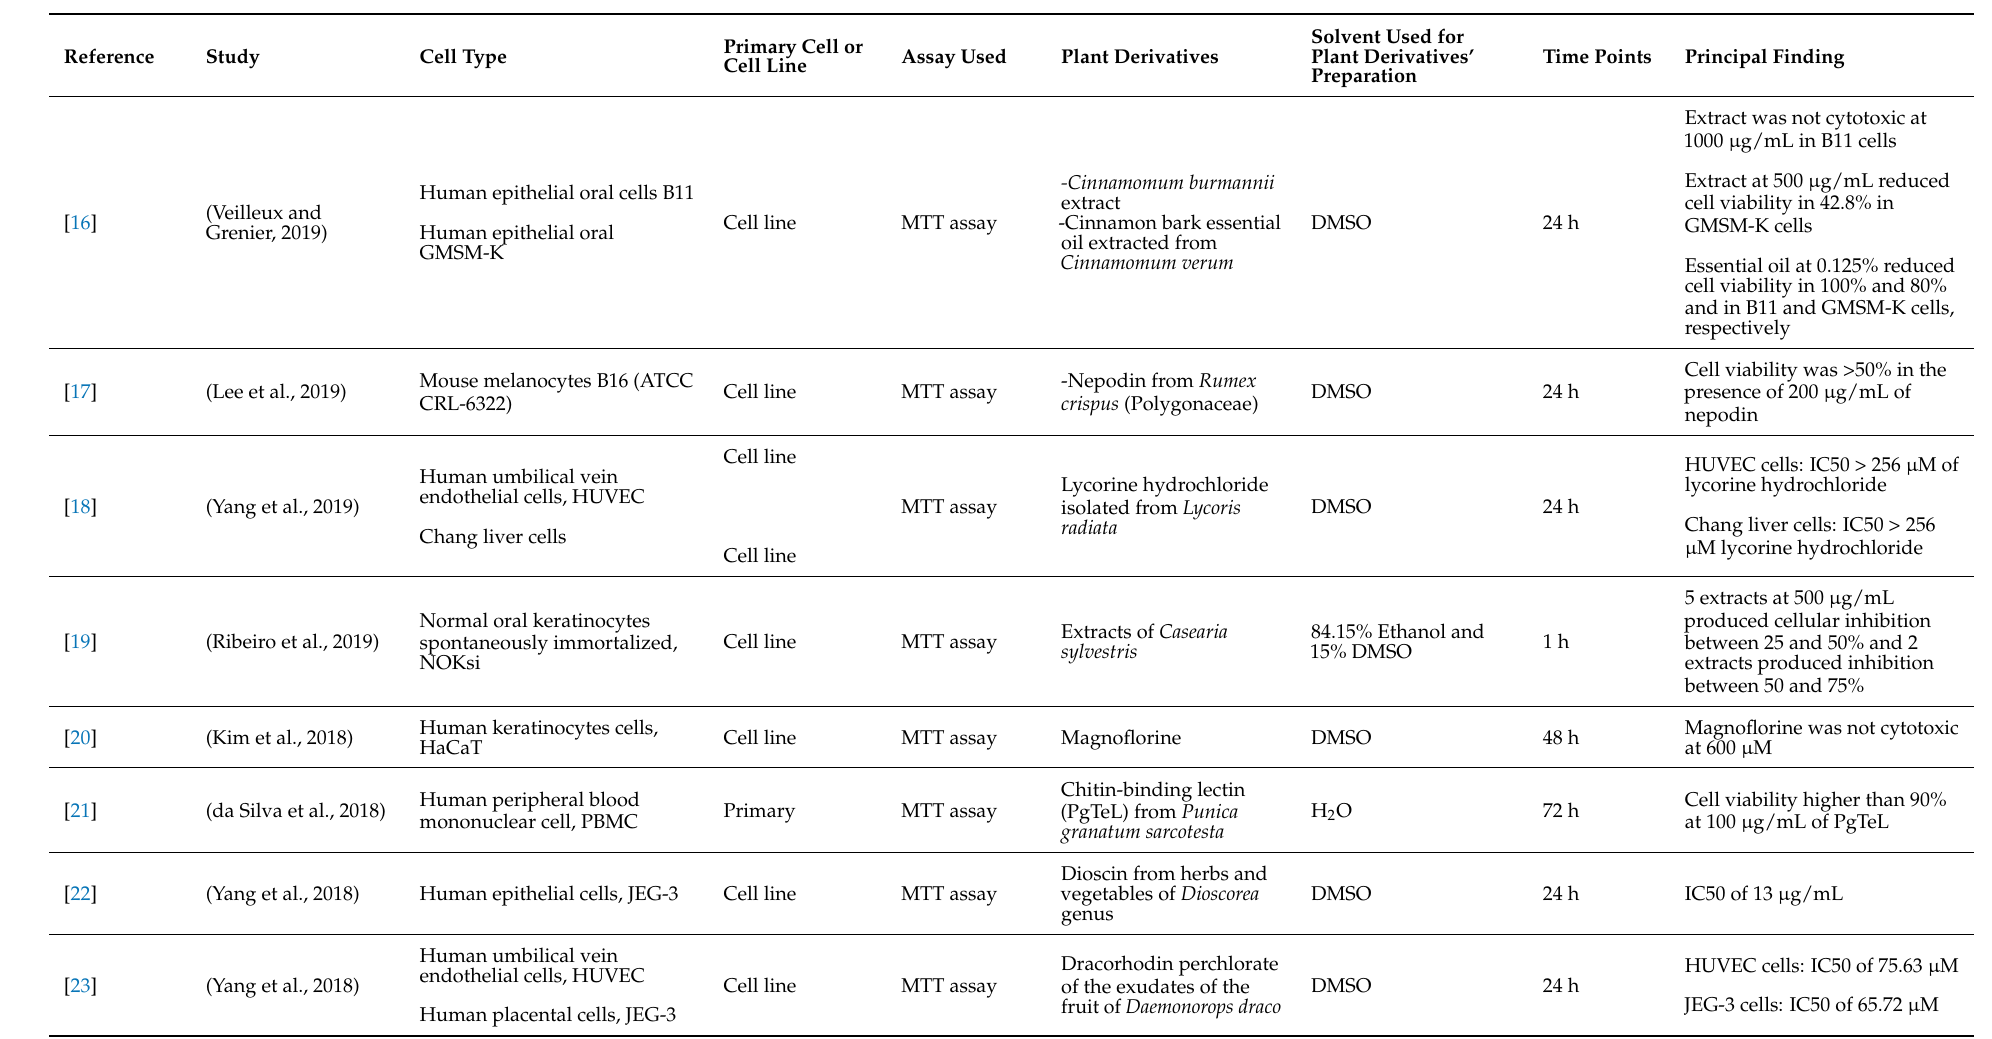
Table 3. Principal findings of the cytotoxic effect of plant